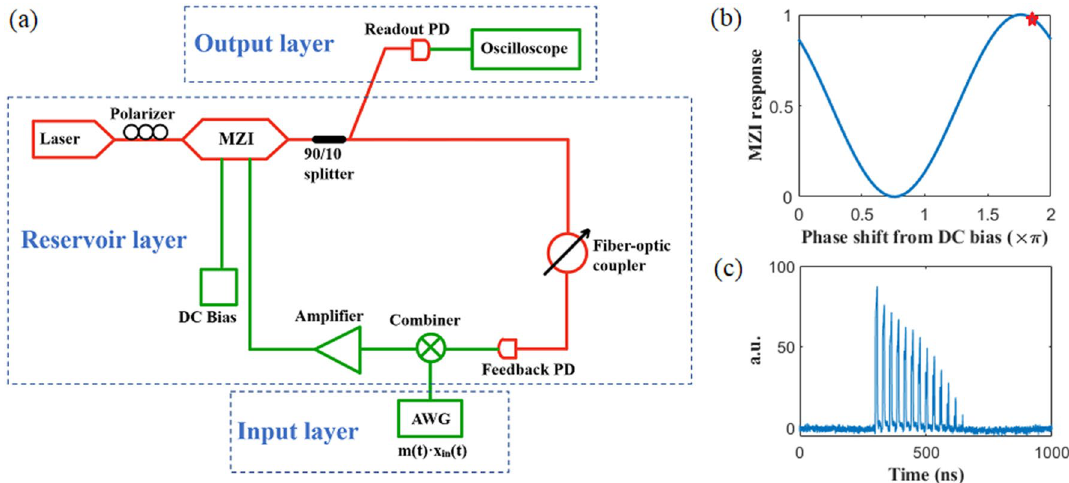
Figure 2. ( a ) Schematic of photonic real-time delay-line reservoir system. ( b ) Transfer function and operating point (marked as a red star) of the MZM ( c ) Spike train characterizing a decaying memory pattern 5 Fig. 2. The nonlinear node of the RC is realized by an optical amplitude modulator (EOSPACE AX-0MSS- 20-PFA-SFA-LV). Adjusting the DC bias, the operation point of the modulator is set at 0.05 π right to the peak of the sinusoidal transfer function, giving ϕ = 0.55 π in Eq. (3). Besides several short fibers used to connect various